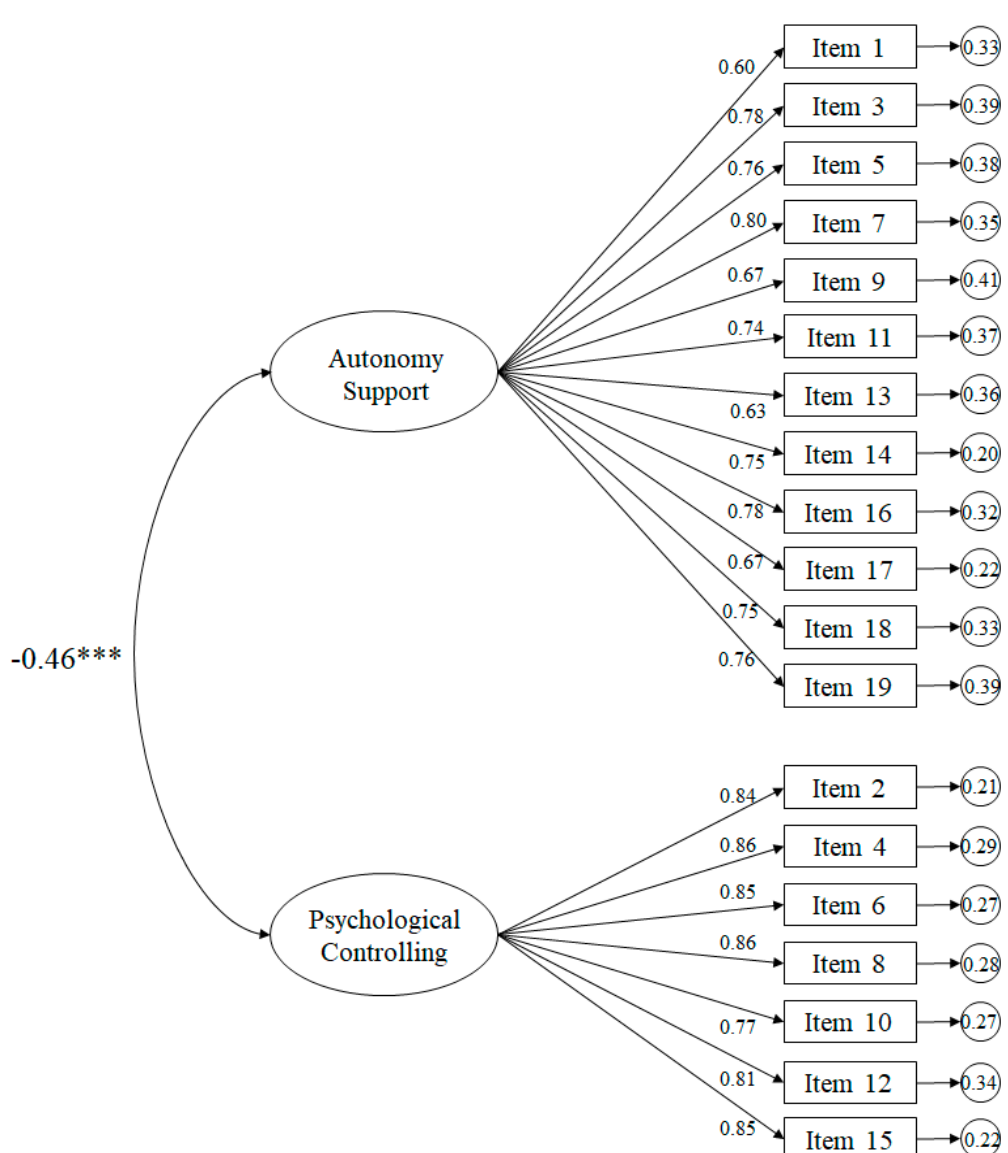
Figure 1. Confirmatory factor analysis of the SPSEC-T. The ellipses represent the factors and the rectangles represent the various items. Residual variances are shown in the small circles. The fit indices of the tested model (Figure 2) related to the parents revealed appropriate fits: χ 2 (151. N = 428) = 555.34, p < 0.001; χ 2 / df = 3.68; CFI = 0.93; IFI = 0.93; RMSEA = 0.079 (IC 90% = 0.072–0.086); SRMR = 0.033. The standardized regression weights ranged from 0.65 to 0.95, and were statistically significant ( p < 0.001). The correlation between the support for autonomy and psychological control factors was − 0.28 and was likewise statistically significant ( p <